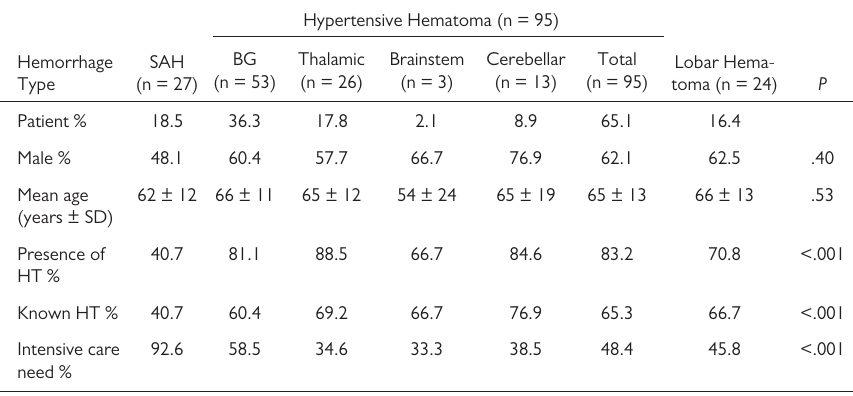
Table 1. Hemorrhagic Stroke Demographics